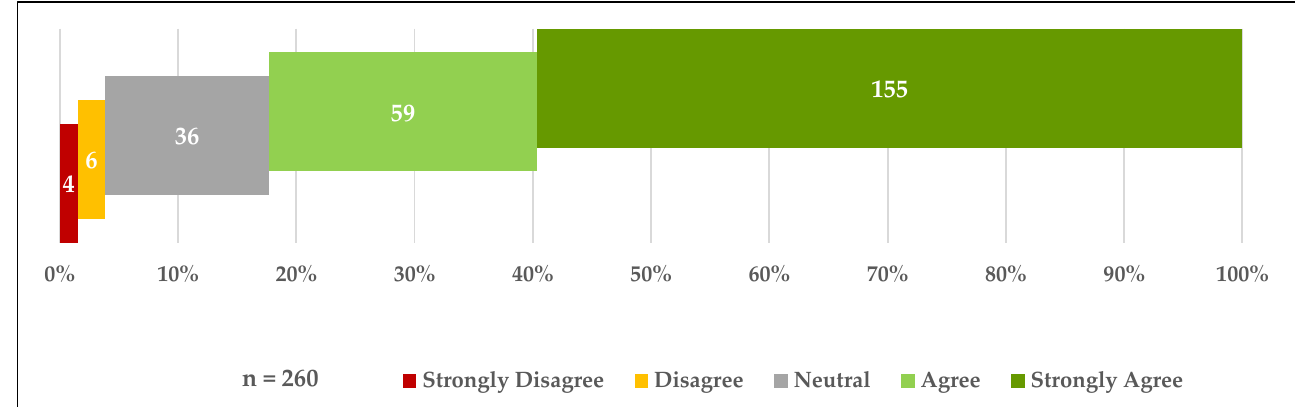
Table 2. Factors influencing trust toward the COVID-19 vaccines provided in Saudi Arabia.